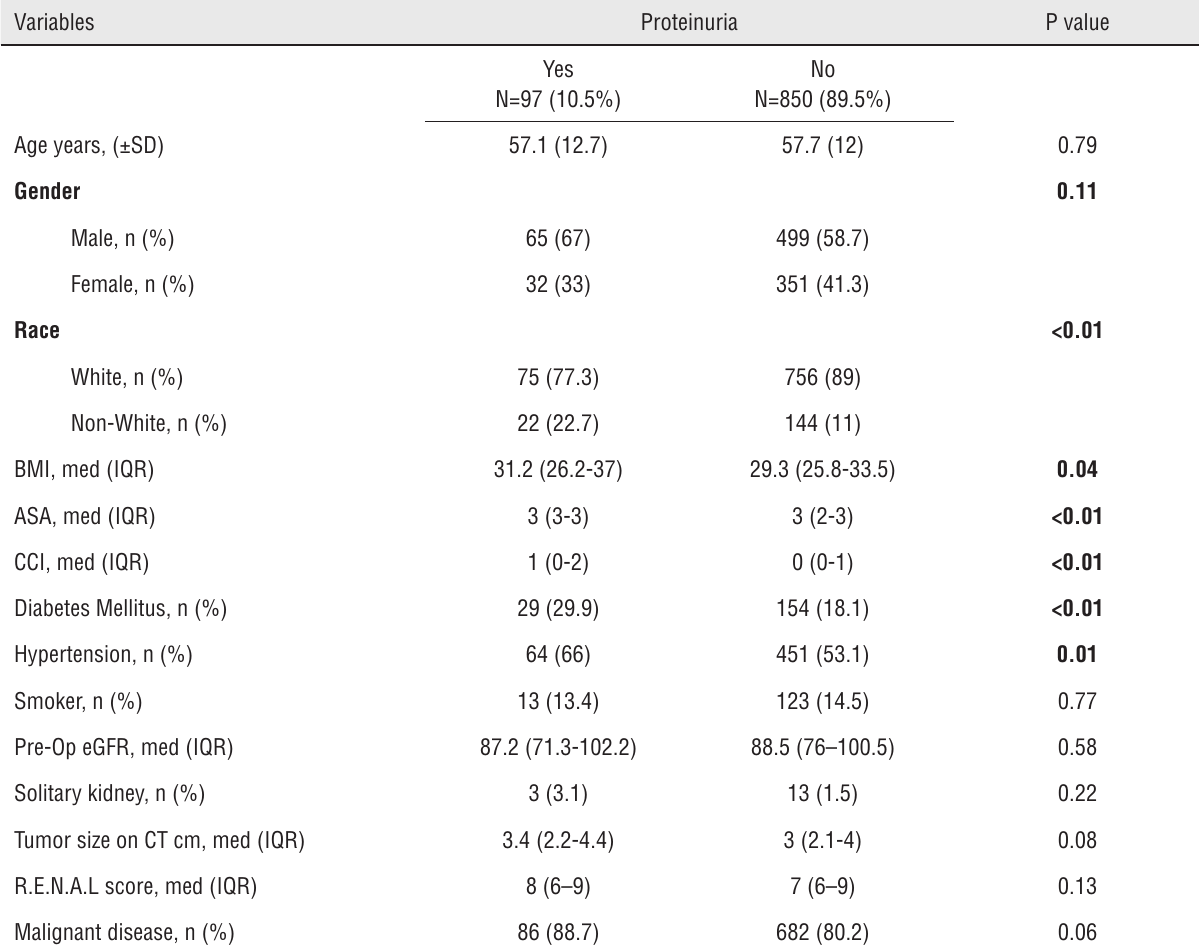
Table 1 - Sample data of the animals submitted to thermoablation using radiofrequency. Table 1 - Patient demographic and tumor